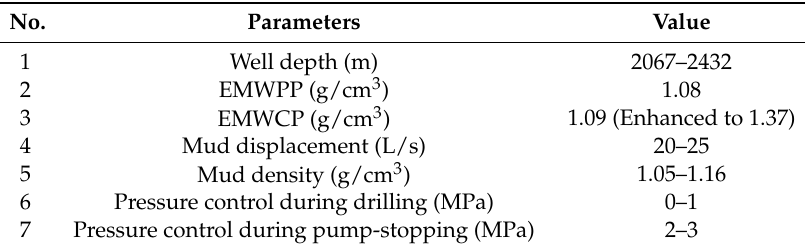
Table 5. Operating parameters of